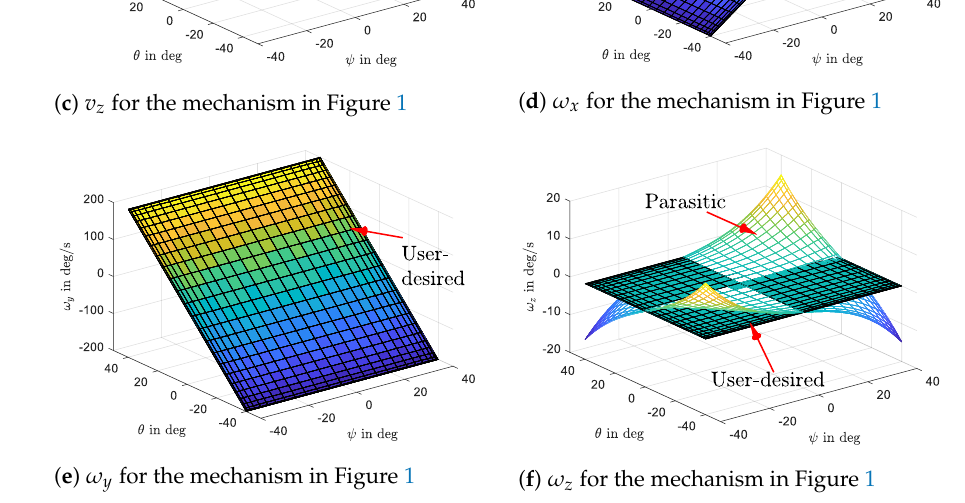
Figure 4. Numerical